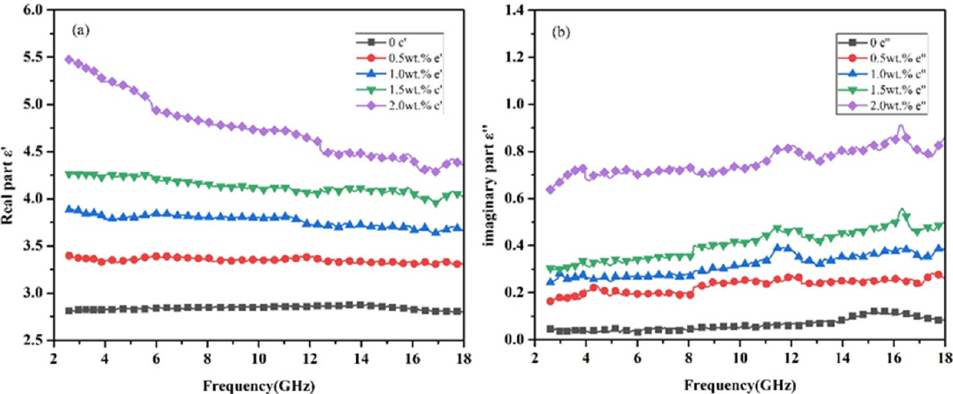
Figure 10. Dielectric properties of rubber-based composites with 1 wt.% CGF and different contents of Gr in the T direction from 2.6 to 18 GHz. ( a ) real part ( b ) imaginary part.